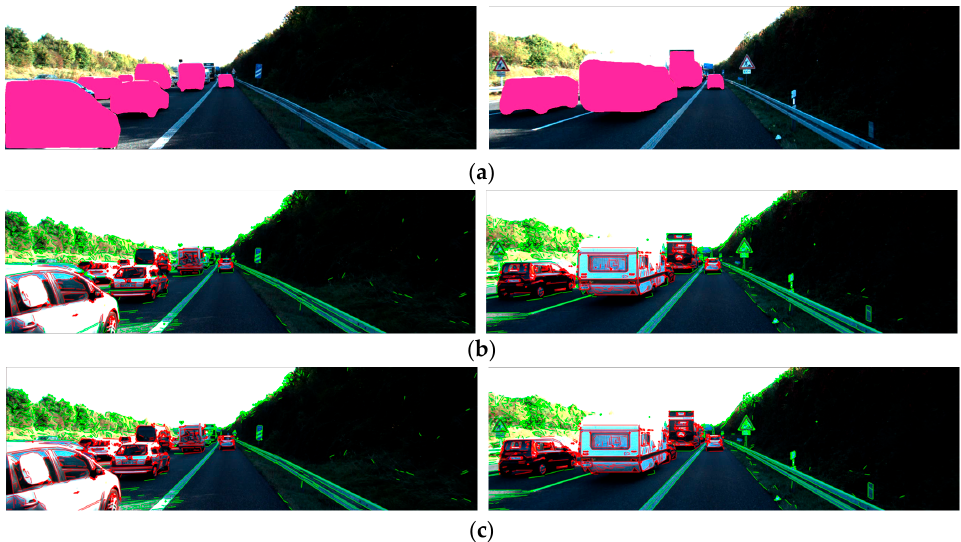
Figure 6. Comparison of dynamic feature probability before and after tracking results. ( a ) Semantic segmentation masks. ( b ) Before dynamic tracking. ( c ) After dynamic probability tracking.